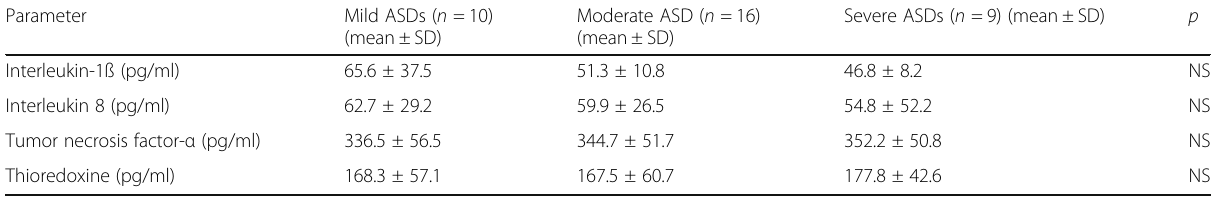
Table 4 The mean serum level of cytokines and thioredoxine in different groups of children with ASD Parameter Mild ASDs ( n = 10) Moderate ASD ( n = 16) Severe ASDs ( n = 9) (mean ± SD) (mean ± SD) (mean± SD)